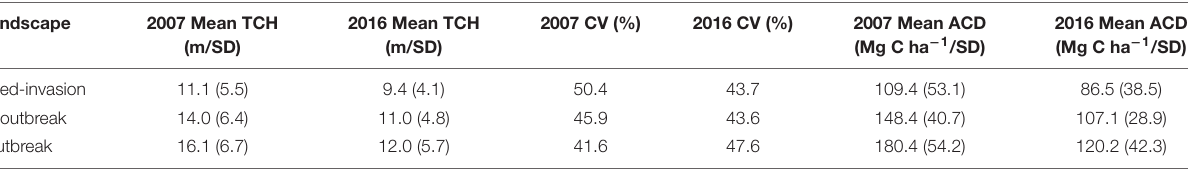
TABLE 3 | Study region summary statistics for top-of-canopy height (TCH), coefficient of variation (CV), and aboveground carbon density (ACD). Study landscape